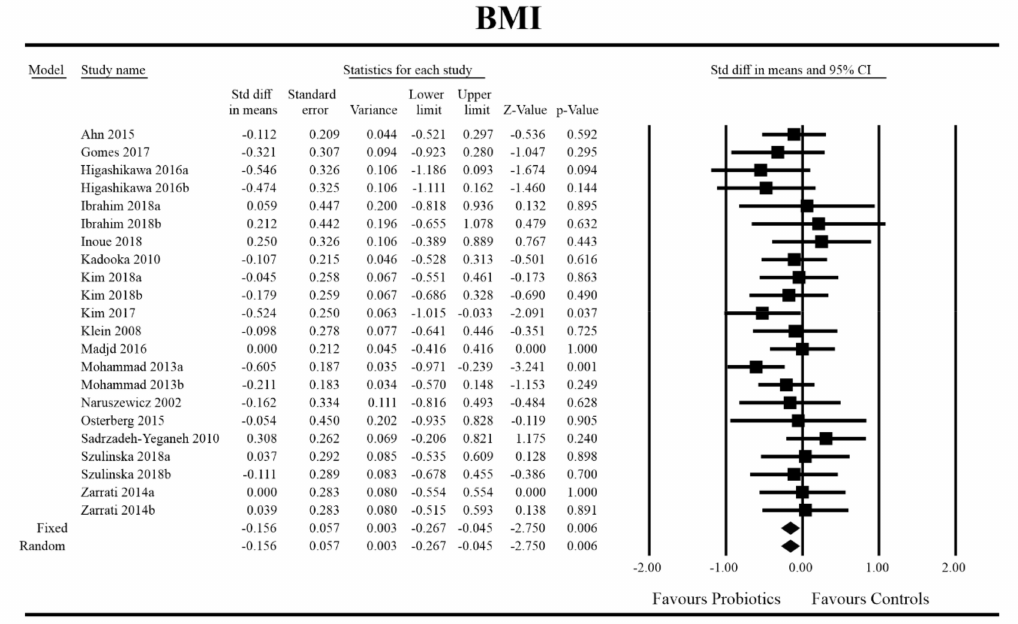
Figure 2. E ff ect size and standardized mean di ff erence for BMI in persons taking probiotics vs. controls (endpoint data). Q = 18.487, df (Q) = 21, p = 0.618, I-squared = 0.0. BMI—body mass index. [31,44,49–51,